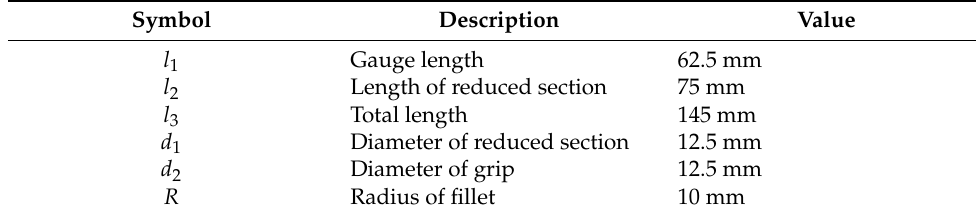
Figure 1. Schematic of the ASTM E8/E8M tensile specimen. Table 1. Dimensions of the specimens.